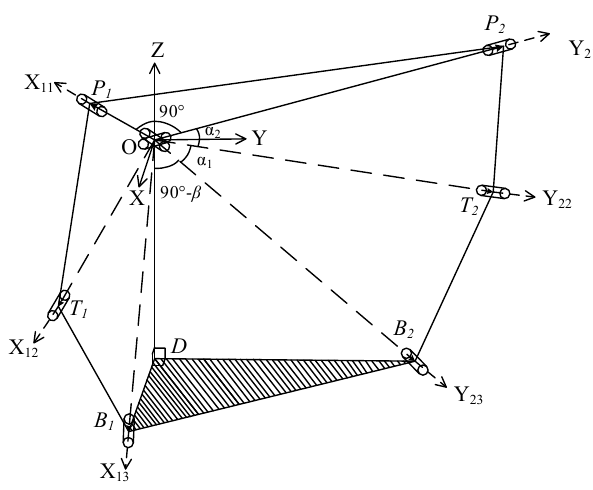
Figure 2. Schematic diagram of the coordinate system.